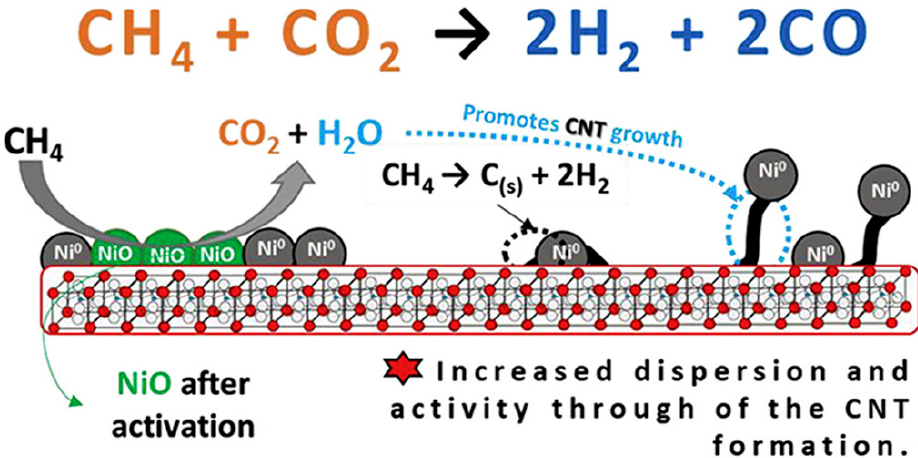
Figure 25. Schematic representation of the growth of carbon nanotubes on Ni/LaAlO 3 with remaining NiO (Reprinted with permission from [19]).